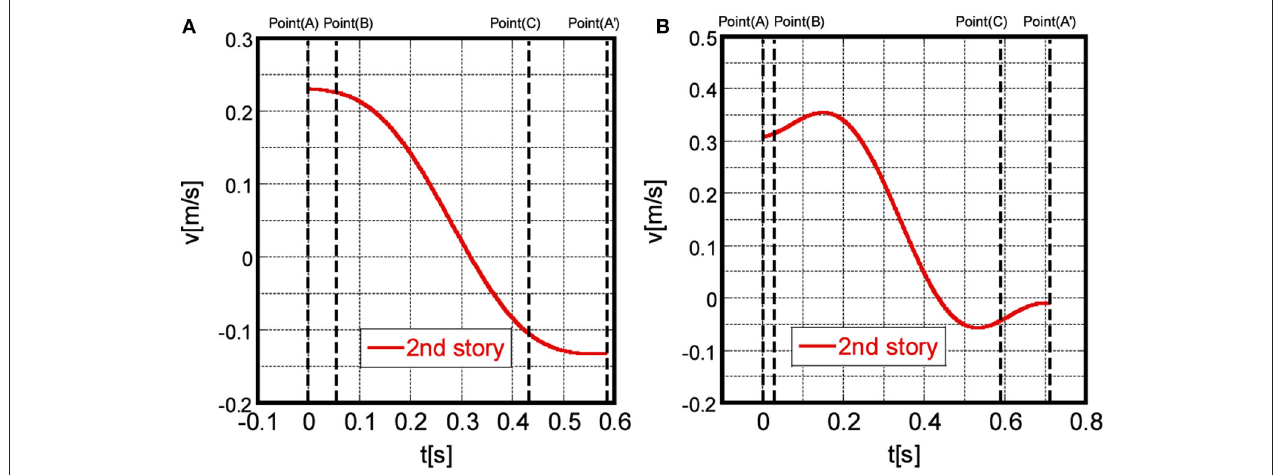
FIGURE 8 | Time histories between Point (A) and Point (A ′ ) of velocity of second-story mass under critical multiple impulse with V = 0.1,0.3 [m/sec], (A) V = 0.1 [m/sec], (B) V = 0.3 [m/sec].